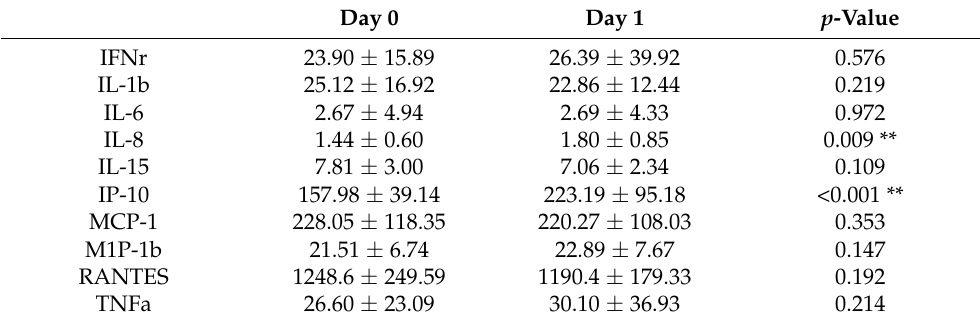
Table 3. Blood cytokine expression in the 48 donors with the ChAdOx1 nCoV-19 vaccine at different time